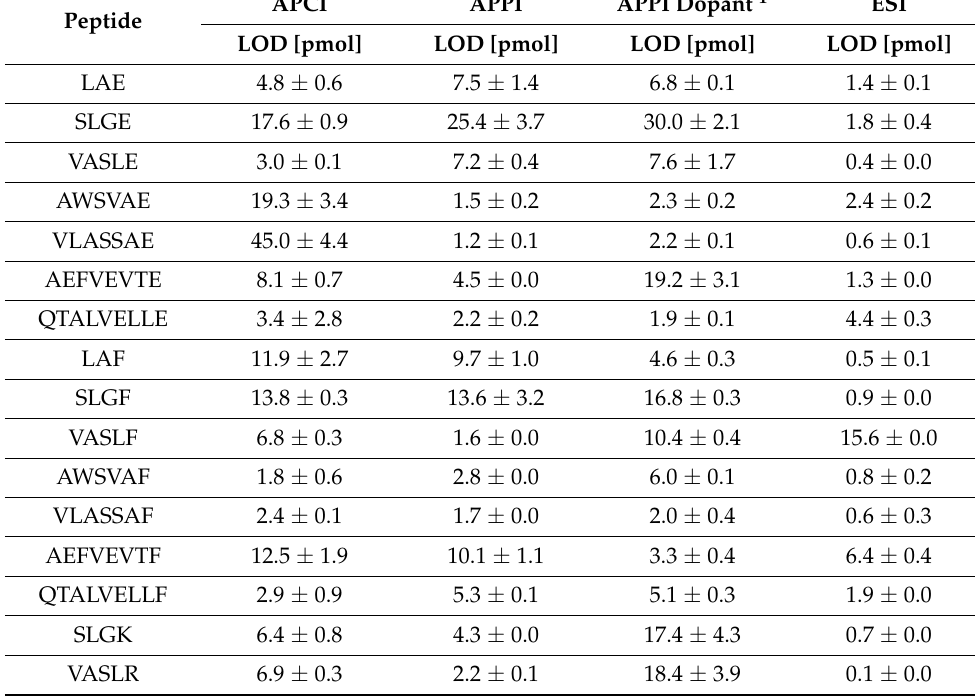
Figure 8. Detection limits of peptide standards are shown in the negative logarithmic scale for ESI, APCI, APPI, and dopant APPI. Data were obtained by FIA using methanol/water (80:20 v/v) mobile phase, flow rate 400 μ L·min − 1 . The error bars represent the standard errors of the mean. Table 1. Limits of detection for peptide standards in atmospheric-pressure chemical ionization (APCI), atmospheric-pressure photoionization (APPI), and electrospray ionization (ESI). The values in pmol ± standard error of the mean (SEM) were obtained by flow injection analysis (FIA)